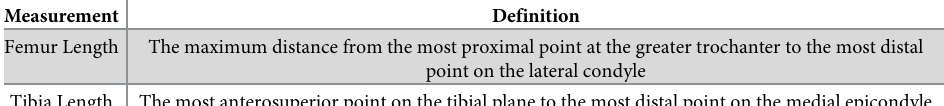
Table 2. Definitions for length measurements for the femur and tibia.